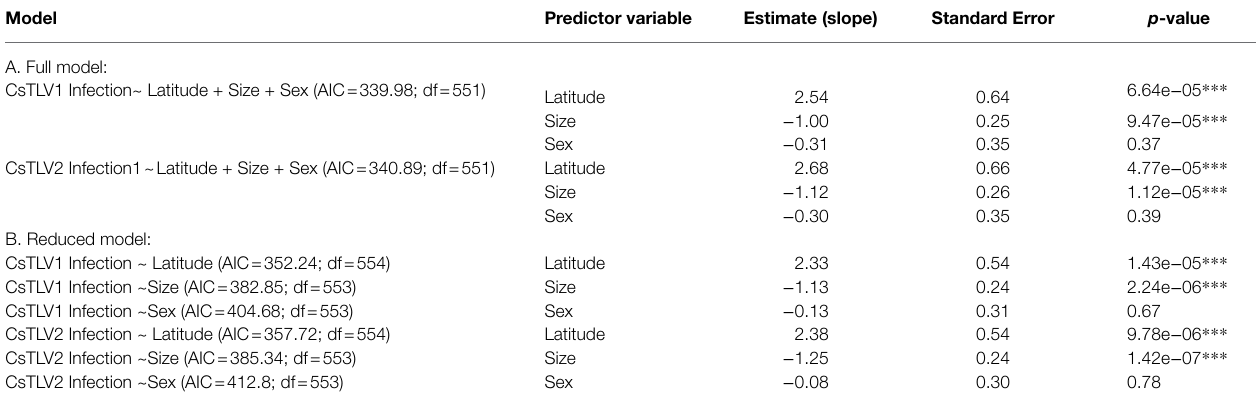
TABLE 4 | Generalized linear model (GLM) with potential effects on CsTLV1 and CsTLV2